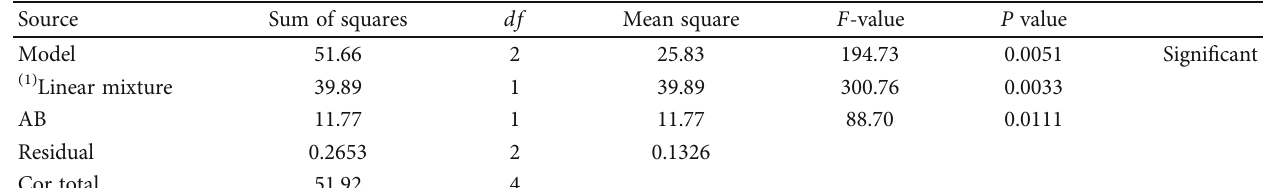
Table 4: Flexural Strength.